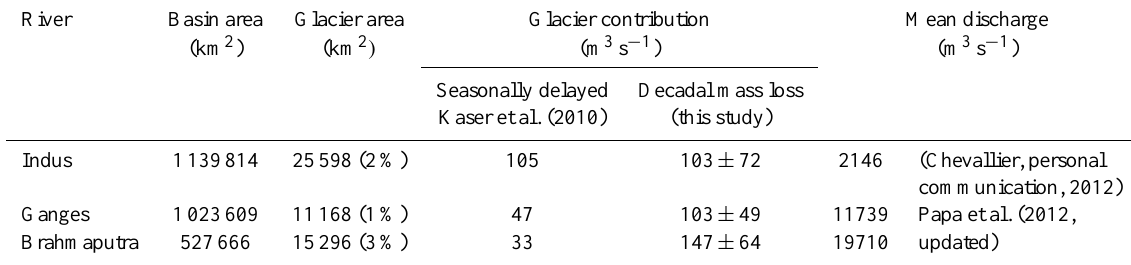
Table 6. Annual average of the glacier seasonal and decadal mass loss contributions to Indus, Ganges and Brahmaputra discharges. Basin area and seasonal contributions are given by Kaser et al. (2010), glacier area in each basin is derived from the RGI v2.0 (Arendt et al., 2012). Numbers in parentheses indicate the percentage of glacierized area within the river basin. Seasonal contributions were modeled by Kaser et al. (2010) based on the CRU 2.0 dataset over 1961–1990 assuming a balanced glacier mass budget. Glacier decadal mass loss contributions are given as annual average over